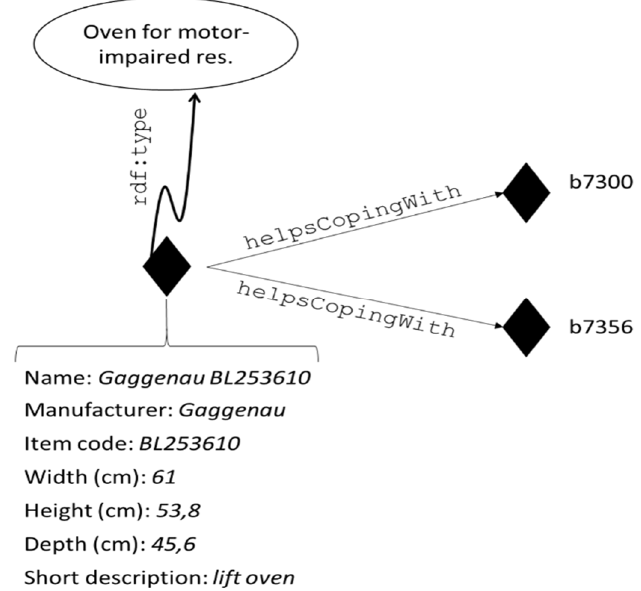
Figure 5. An example of an oven, classified as helpful for dwellers with motor impairments. Individuals are represented with diamonds, concepts are represented with circles, and roles are represented with arrows. The type of an individual is stated with a curved arrow, while datatype properties are collected under the square bracket.